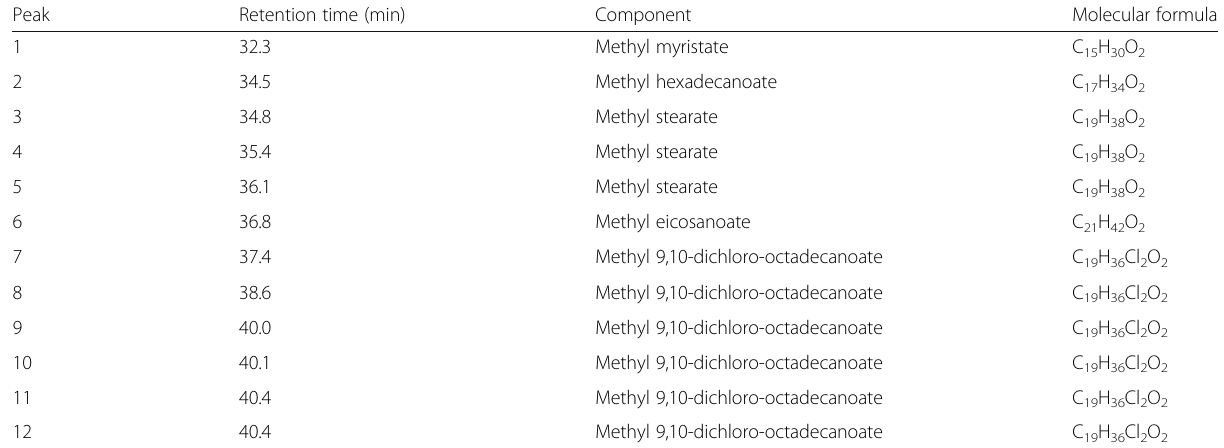
Table 2 Composition of CFAME identified by comparing the experimental mass spectra of the components in Fig. 3 against NIST08 mass spectral library Peak